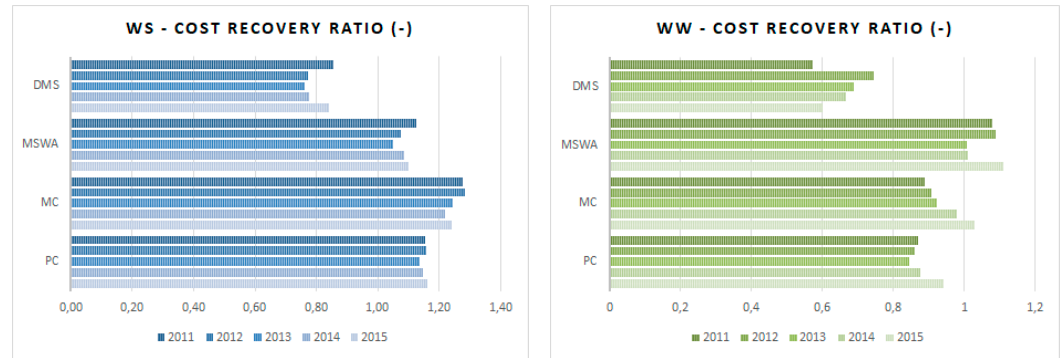
Figure 14. Evolution of cost coverage in water (left) and wastewater services (right).